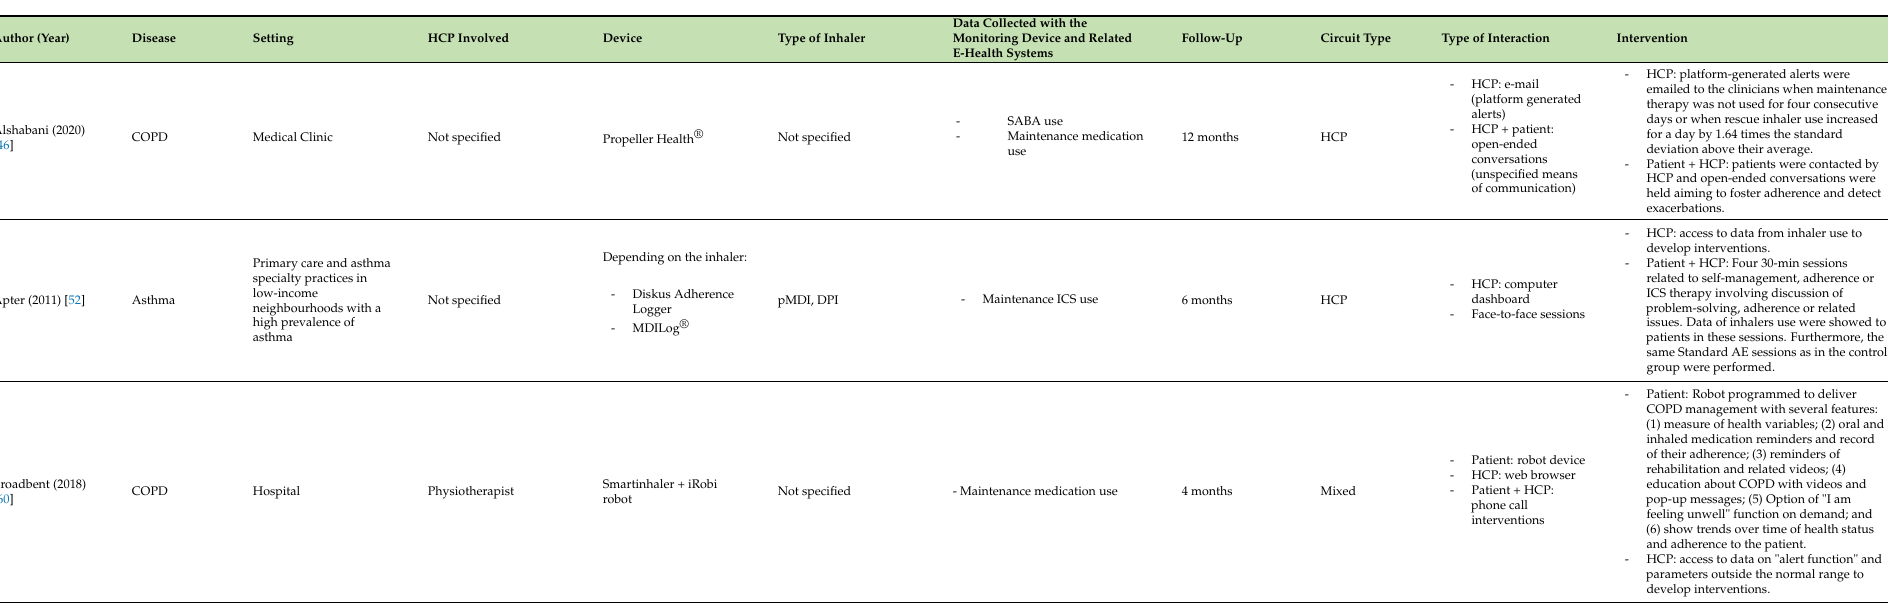
Table 2. Summary of methodology and interventions by studies. ACT (Asthma Control Test); AE (asthma education); CAT (COPD assessment test); COPD (chronic obstructive pulmonary disease); DPI (dry-powder inhaler); HADS (Hospital Anxiety and Depression Scale); HCP (healthcare professionals); ICS (inhaled corticosteroid); pMDI (pressurised Metered Dose Inhaler); POEMS (Polymedication Electronic Monitoring System); SABA (short acting beta agonist); SGRQ (St. George’s Respiratory